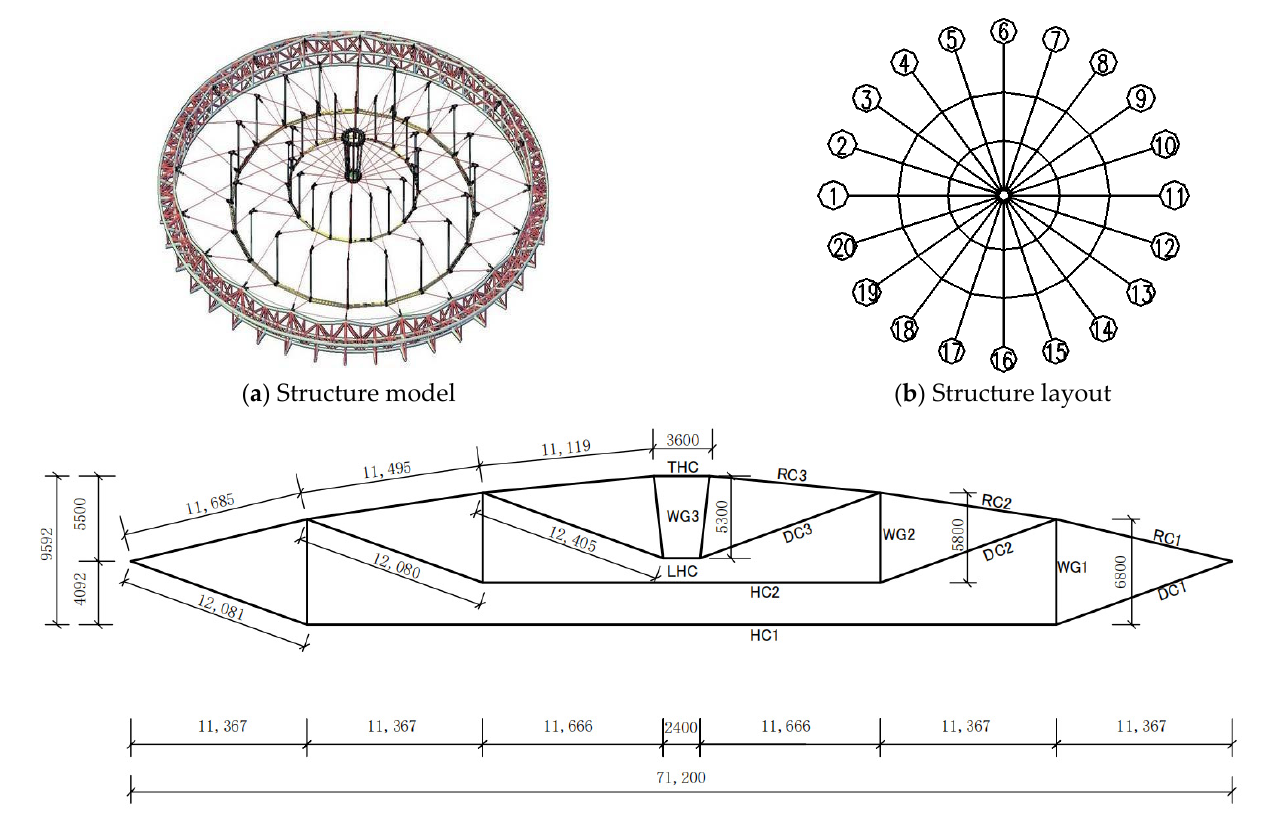
( b ) Structure layout